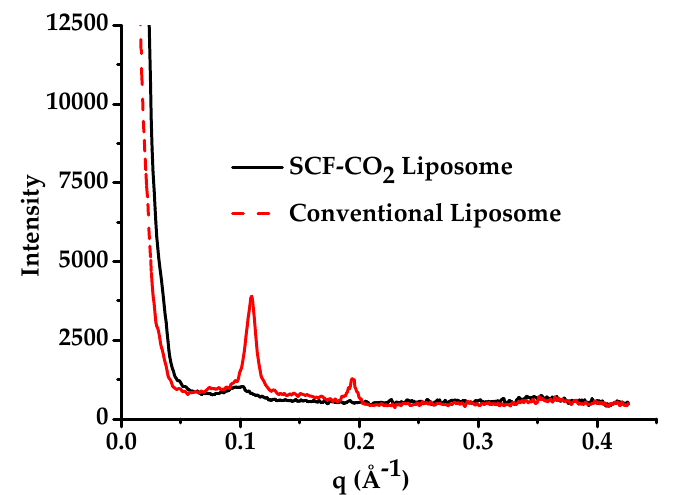
Figure 5. Small-angle X-ray scattering (SAXS) curves of liposomal AmB prepared by the SCF-CO 2 and conventional method liposomes.